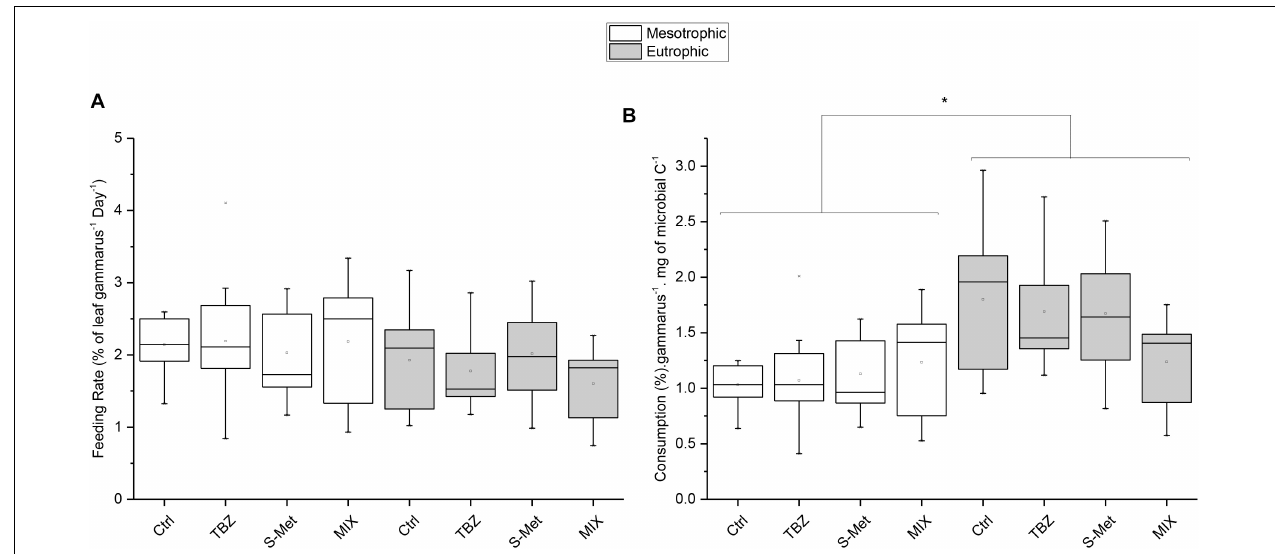
FIGURE 4 | Gammarus fossarum feeding rates expressed in % of leaf ingested per Gammarus and (A) and mg of fungal carbon ingested per Gammarus (B) for leaves exposed to fungicide (TBZ), herbicide (S-Met), both fungicide + herbicide (MIX) or non-exposed (Ctrl), in either mesotrophic (white fill) or eutrophic (gray fill) nutrient condition. Values are median + quartiles 1 and 3 ( n = 9). Differences between nutrient conditions are represented by an asterisk (Kruskal–Wallis, P <